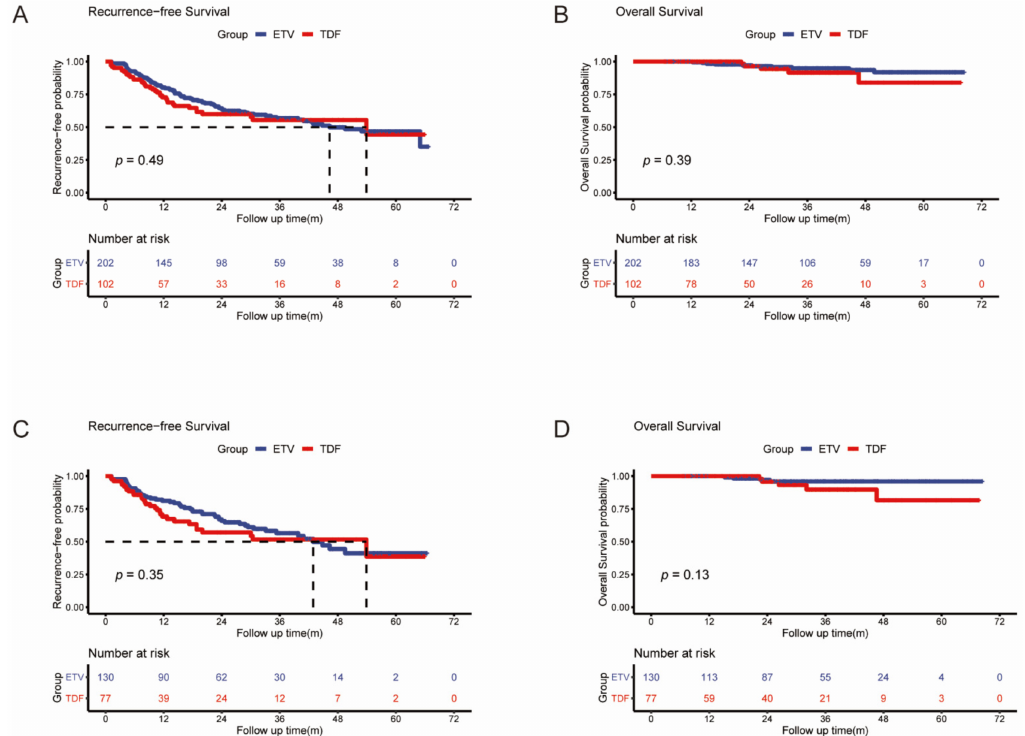
Figure 2. Kaplan–Meier curves of HCC recurrence ( A ) and overall survival ( B ) after RFA between the two groups in the full cohort; Kaplan–Meier curves of HCC recurrence ( C ) and overall survival ( D ) after RFA between the two groups in the matched